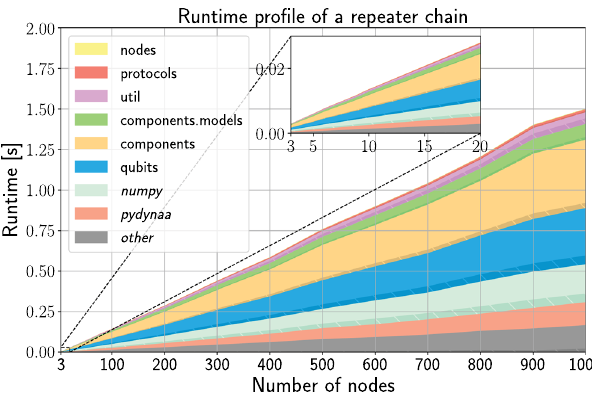
Fig. 9 Runtime pro fi le of a repeater chain simulation using Netsquid. Runtime pro fi le for a repeater chain simulation with a varying number of nodes in the chain. The maximum quantum state size is four qubits. The total time spent in the functions of each NetSquid subpackage and its main package dependencies (in italics) is shown. The dark hatched bands show the largest contribution from a single function in each NetSquid sub- package, as well as in NumPy and uncategorised ( other ) functions. The sub- packages are stacked in the same order as they are listed in the